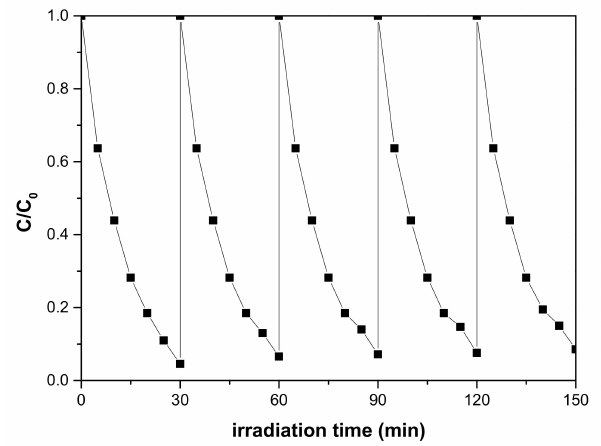
Figure 8. Cycling degradation MB of flower-like TiO 2 with 10 h reaction time under the UV-vis light irradiation.